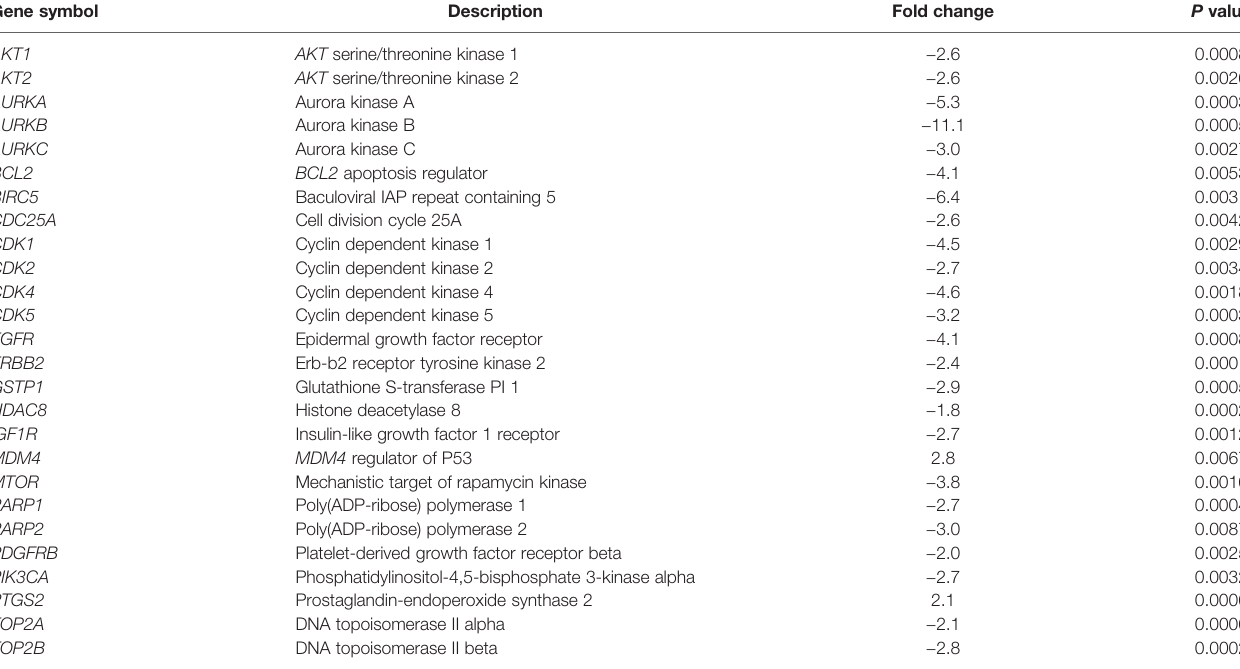
TABLE 2 | The effect of lapachol-containing ruthenium complex ( 2 ) on gene expression of DU-145 cells. Gene symbol Description Fold